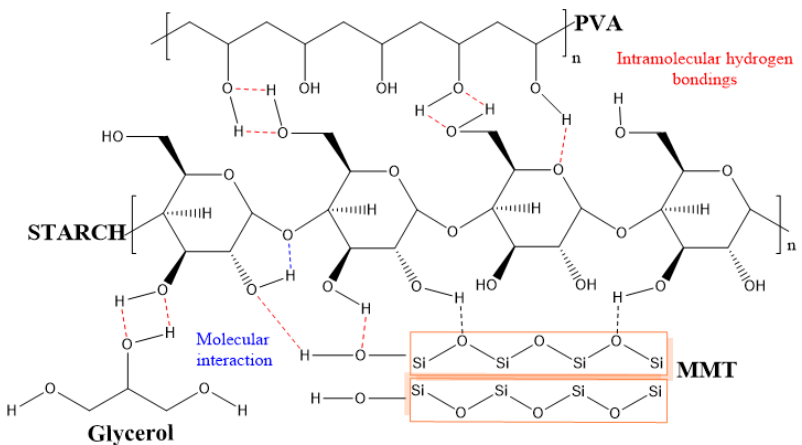
Figure 5. Schematic illustration of proposed molecular interactions between polymers (starch and PVA), plasticizer (glycerol), and MMT nanoclay.